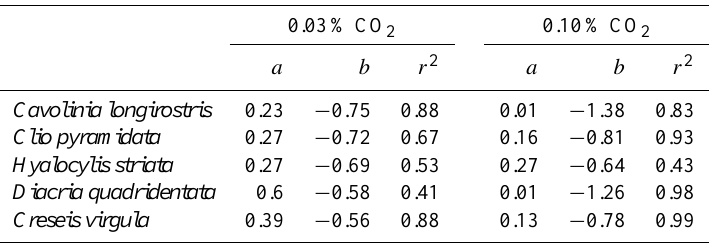
Table 3. Scaling curves describing the relationship between wet mass ( M,g ) and oxygen consumption rate ( R , µmolO 2 g − 1 h − 1 ) following the relationship R = aM b (Fig. 2).